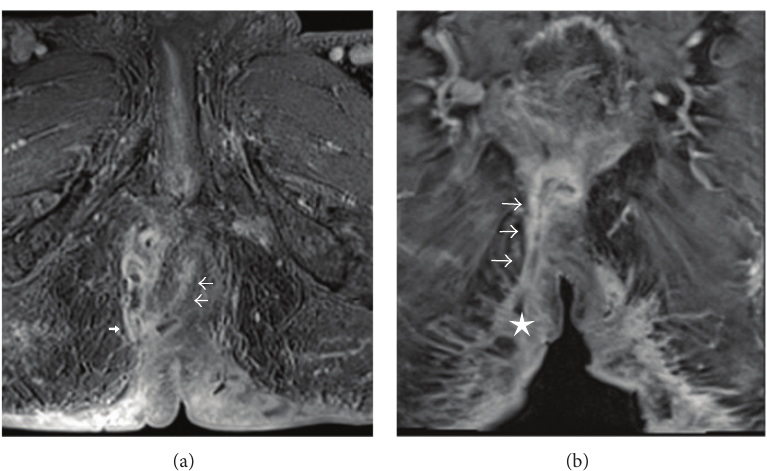
Figure 4: Axial T1-weighted fat-suppressed axial (a) and coronal (b) images postcontrast in an MRI pelvis done 3 years before presentation using fistula-in-ano protocol demonstrates an enhancing transphincteric fistula tract at 6 o’clock position (white arrows in both images) extending to the right ischioanal space (thick arrow) with cutaneous opening at the right gluteal region (star).